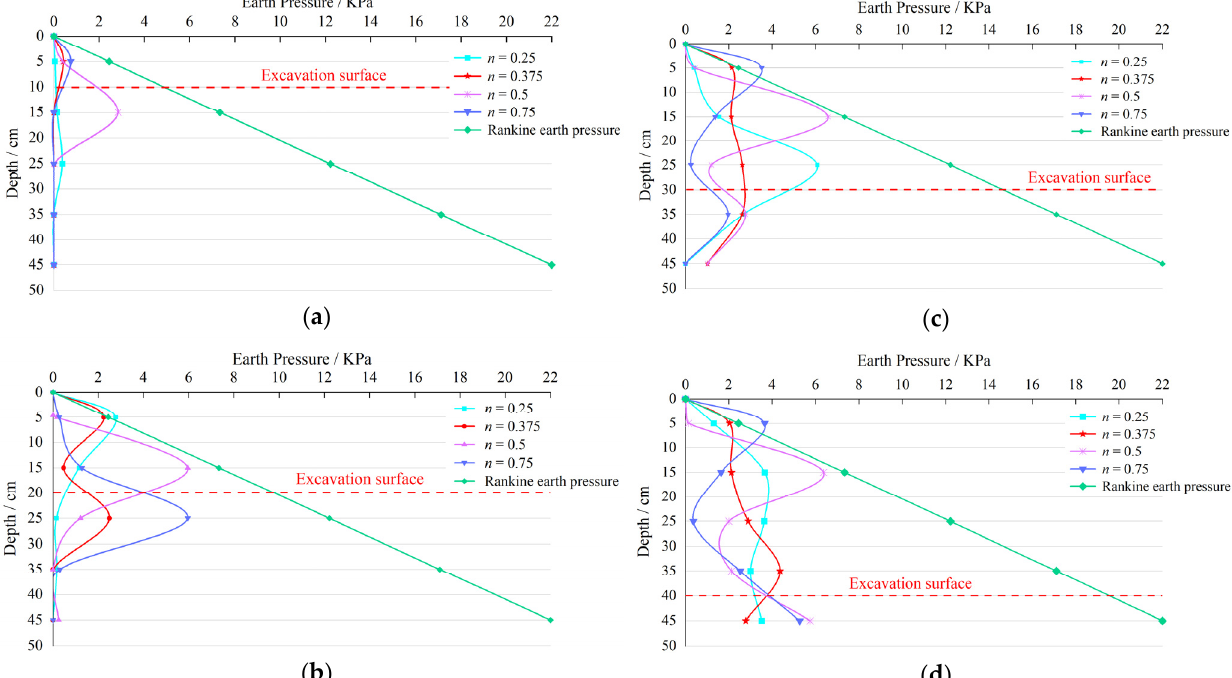
Figure 11. The earth pressure monitored from model test during the excavation process: ( a ) process 1, ( b ) process 2, ( c ) process 3, ( d ) process 4.